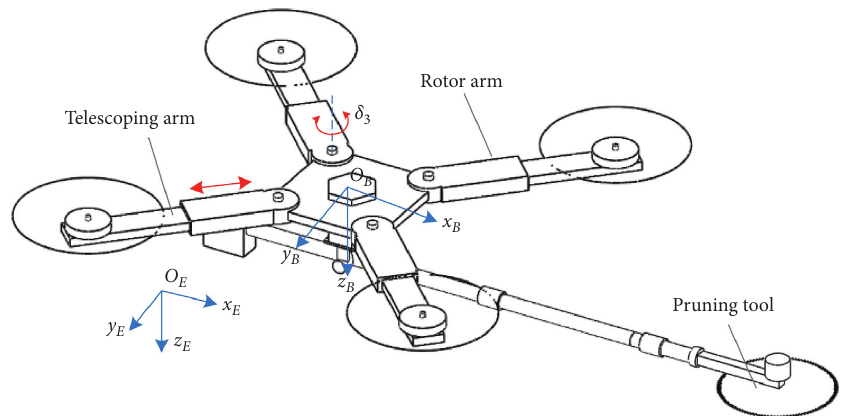
Figure 1: Frames of actively deformable aerial